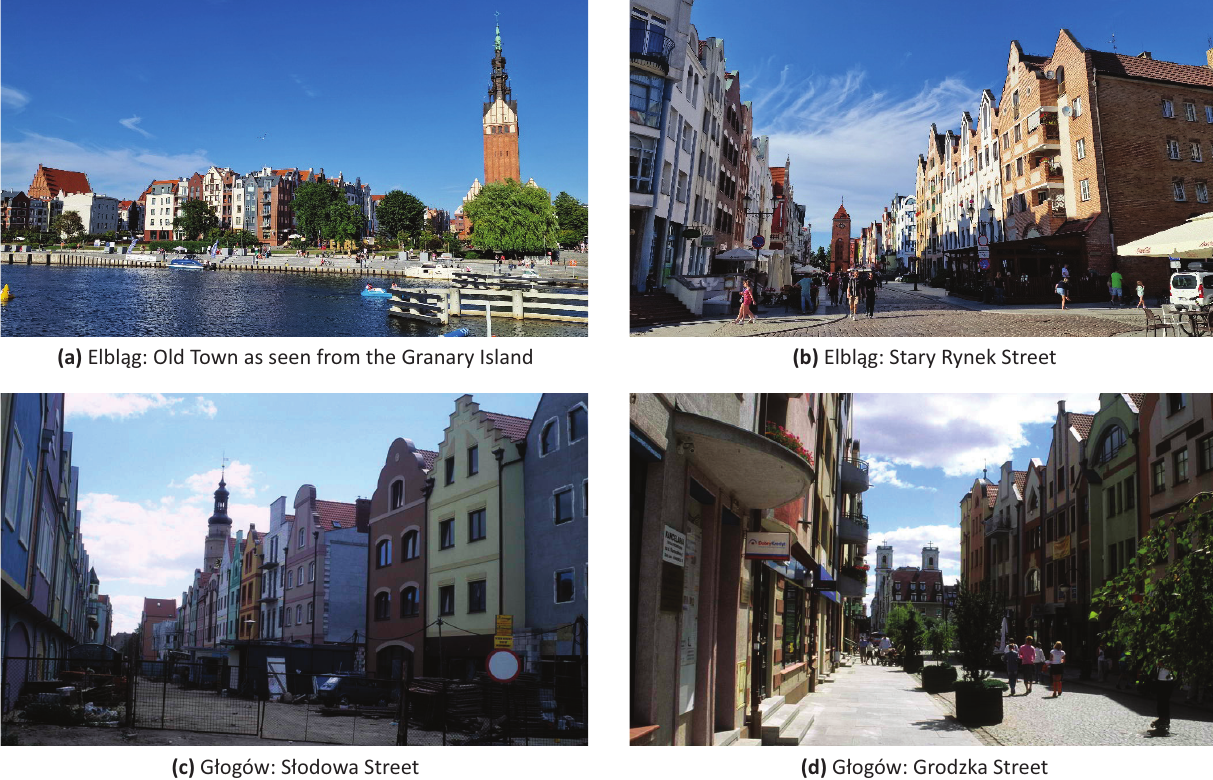
Figure 4. Selected examples of the structures rebuilt according to the rules of retroversion. Urban Planning, 2023, Volume 8, Issue 1, Pages